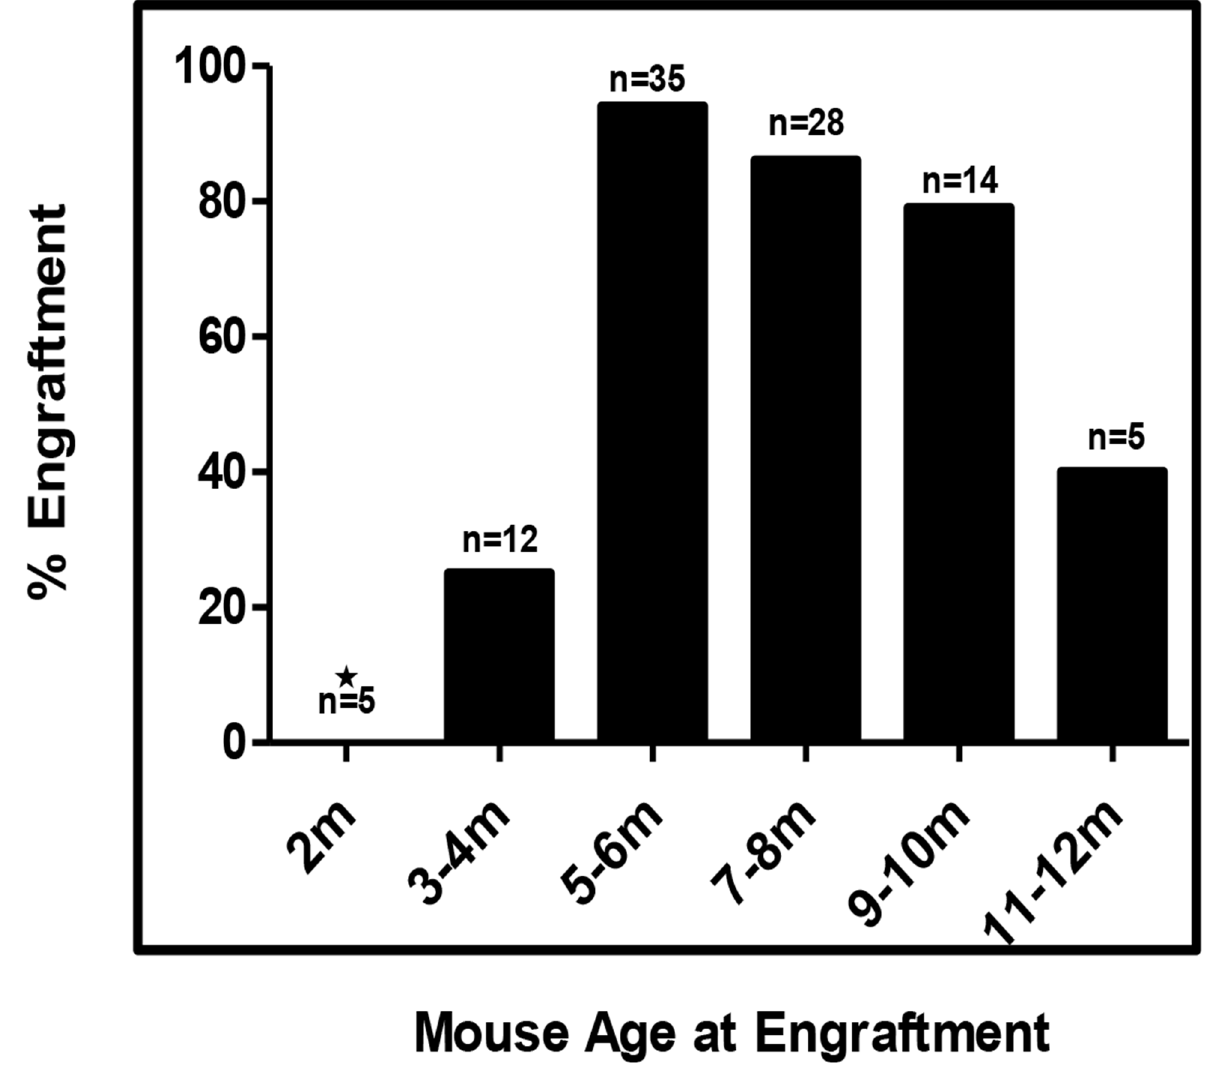
Figure 4. Percentage of mice successfully engrafted at various ages. One hundred mice at different ages at the time of engraftment with human hepatocytes were evaluated for successful engraftement by measuring human albumin concentration in the serum. Mice were considered successfully engrafted if we measured >100 ug/mL of human